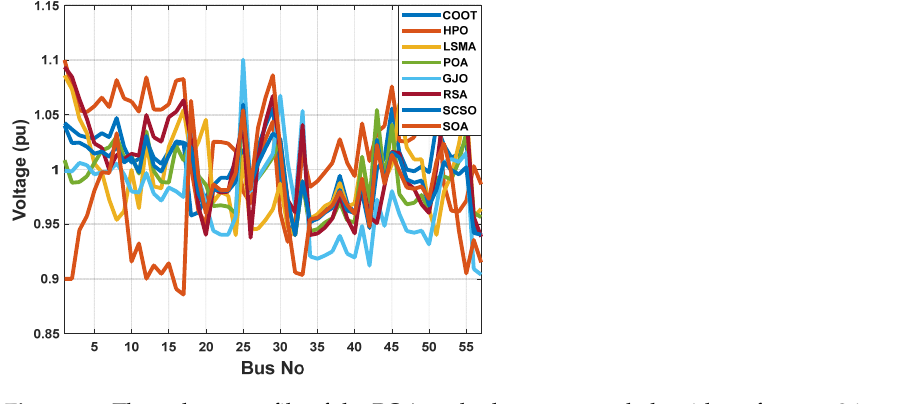
Figure 23. The voltage profile of the POA and other compared algorithms for case 2 in a standard IEEE 57-bus test system.